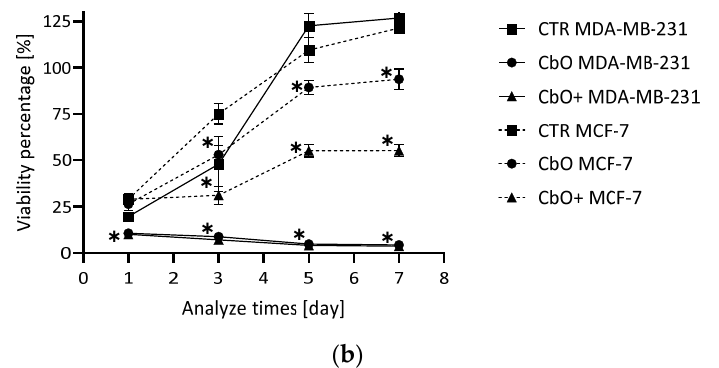
Figure 3. CbO double metabolic inhibitor combination evaluation. ( a ) Viability test (crystal violet staining) after 72 h. Black: MDA-MB-231, Grey: MCF-7 and Hatched: MCF-10; n = 6, average ± SD, significance: * p < 0.05. ( b ) Proliferation test (crystal violet staining) during 7 days of measuring at days 1, 3, 5 and 7. Full lines: MDA-MB-231 and Hatched lines: MCF-7; n = 6, average ± SD, significance: * p < 0.05. CTR: control condition, CbO: CB-839 50 nM and Oxamate 20 mM and CbO+: CB-839 1 µM and Oxamate 50 mM.